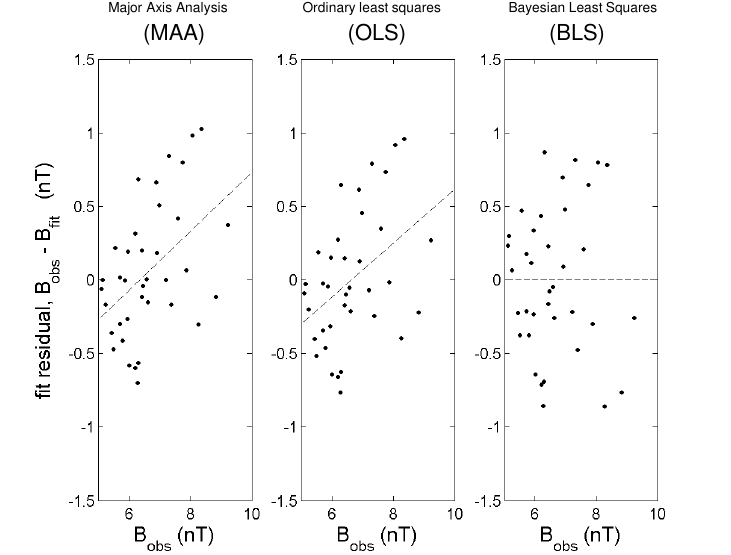
Figure 25: Analysis of the fit residuals in the fit of 𝐼𝐷𝑉 against 𝐵 using: (left) MAA; (middle) OLS; and (right) (BLS). The fit residuals ( 𝐵 obs − 𝐵 fit ) are shown as a function of 𝐵 obs , where 𝐵 obs is the observed value and 𝐵 fit is the fitted value from the 𝐼𝐷𝑉 index. The dashed line is the linear regression fit to the points to highlight trends. The OLS and MAA fit residuals show strong trends and so should not be used because 𝐵 fit is consistently an overestimate of 𝐵 obs when 𝐵 obs is small and consistently an underestimate of 𝐵 obs when it is large. Hence, these fits seriously underestimate the real trend in the data. In contrast, the BLS regression is free of such a